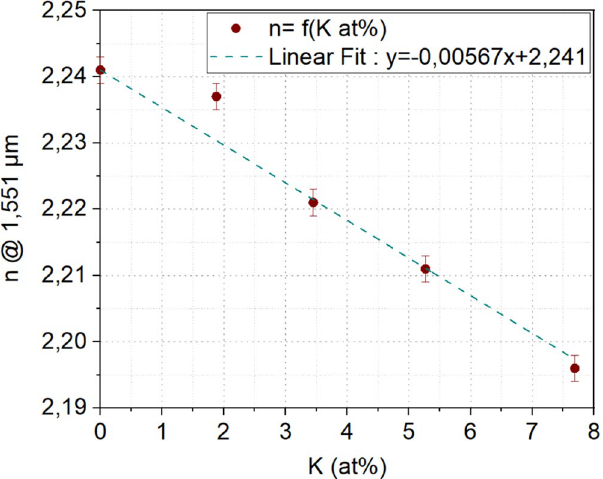
Figure 6. Glass index as a function of the rate of potassium ions in the (72 GeSe 2 –28 Ga 2 Se 3 ) 75 (KI x –NaI 1−x ) 25 glass composition with x = 0, 0.25, 0.5, 0.75 and 1.